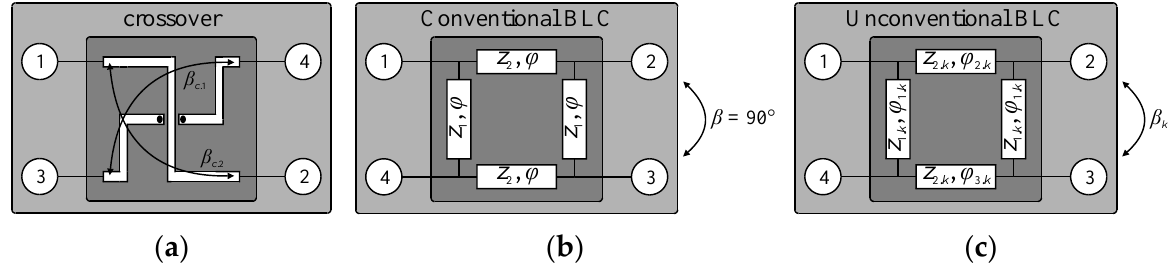
Figure 5. Crossover and hybrid BLCs configurations: ( a ) crossover structure with highlight on phase shifts between crossed TLs (desired phase shift of the crossover is β c = β c .1 = β c .2 ), ( b ) conventional BLC with z 1 = 0.707, z 2 = 1, and ϕ = 90 ◦ (phase shift: β = 90 ◦ ), and ( c ) modified BLC circuit with extra degrees of freedom ϕ 2 .k , ϕ 3 .k w.r.t. conventional design that enables adjustment of phase shift β k (the parameters z 1 and z 2 are normalized w.r.t. Z 0 = 50 Ω).